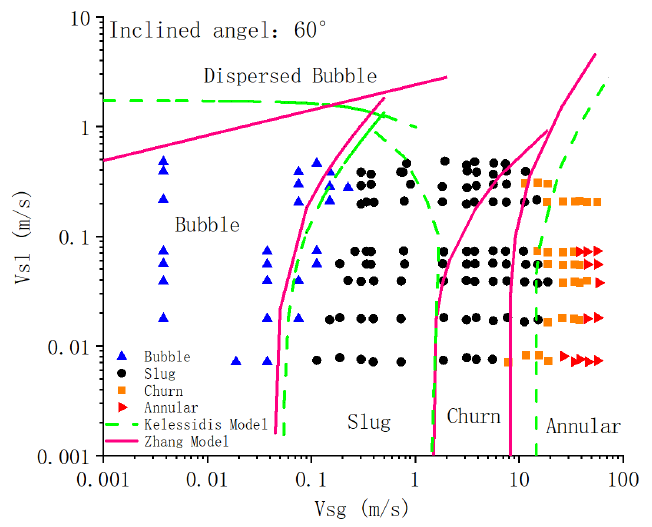
Figure 7. Comparison between flow pattern diagrams of different models and experiments with 60° inclination angle.